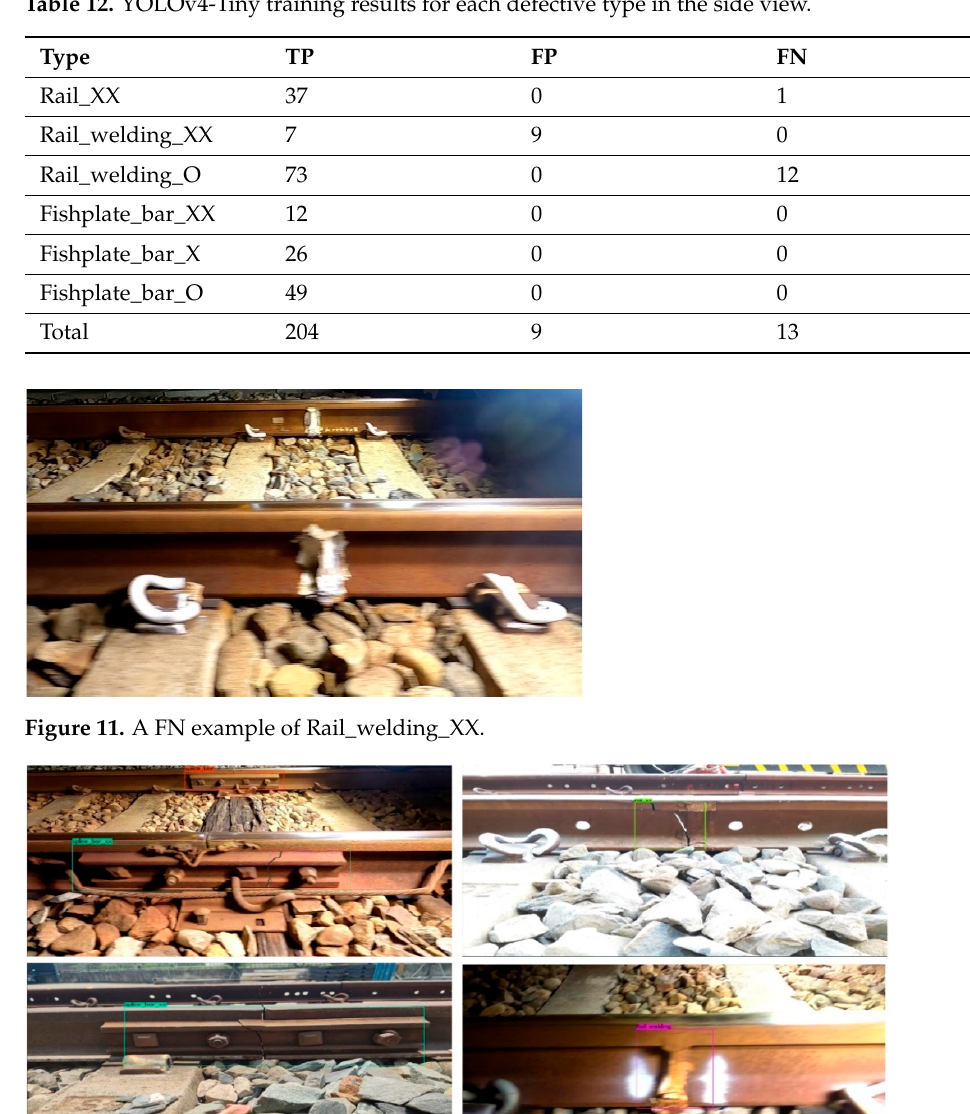
74 Table 14. YOLOX ‐ Tiny training results for each defective type in the side view. Type